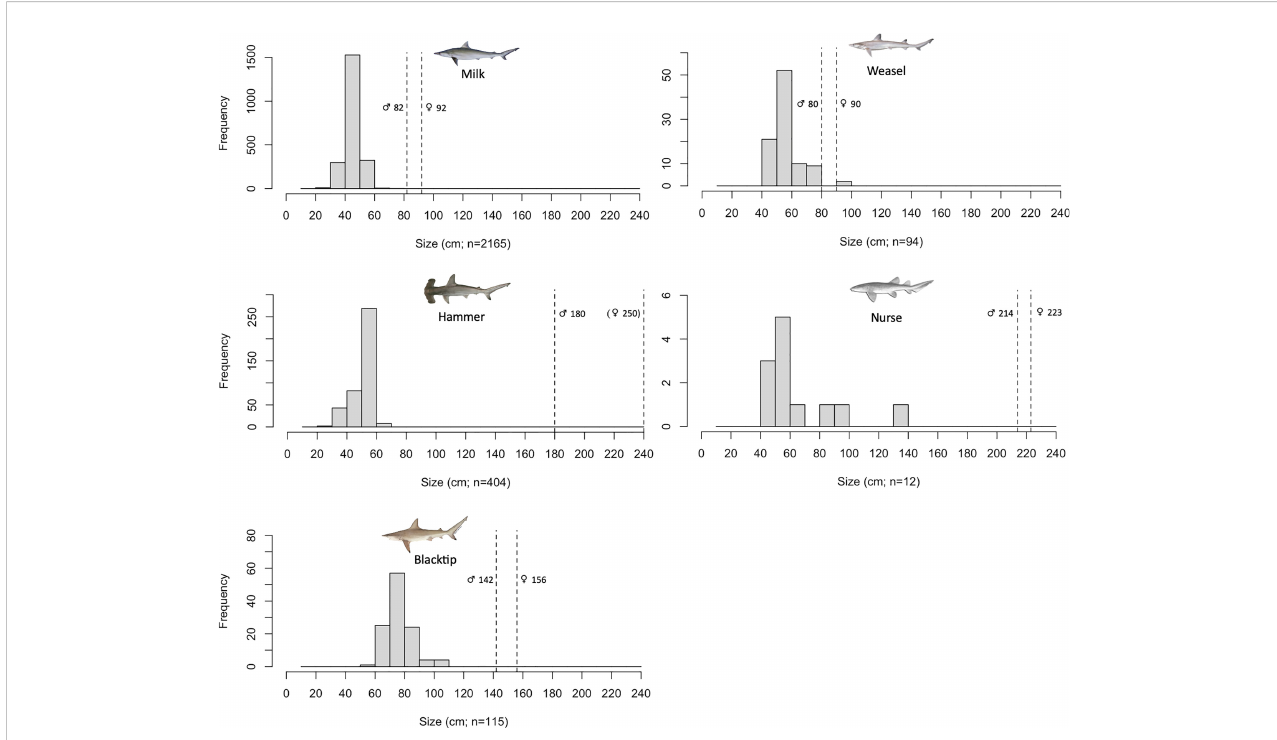
FIGURE 3 Length distributions of juvenile milk ( Rhizoprionodon acutus ), scalloped hammerhead ( Sphyrna lewini ), blacktip ( Carcharhinus limbatus ), Atlantic weasel ( Paragaleus pectoralis ) and nurse ( Ginglymostoma cirratum ) sharks in Sal Rei Bay, Boa Vista Island, Cabo Verde. Vertical dashed lines represent species ’ length at fi rst maturity for both males and females (see respective references in Supplementary Table